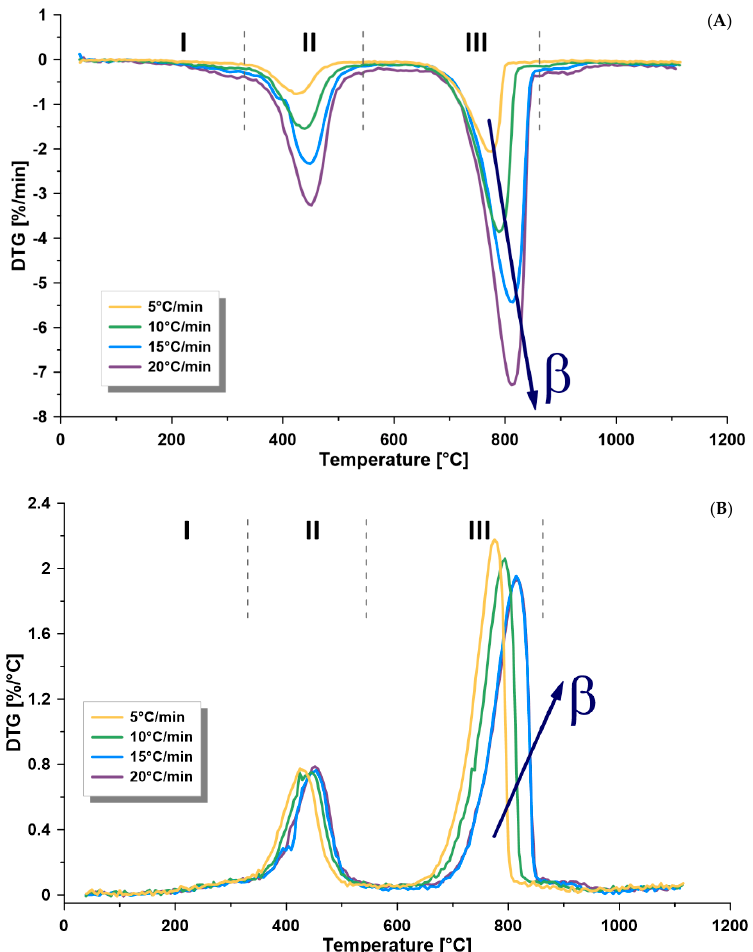
Figure 2. First derivative thermogravimetric (TG) curves, with respect to ( A ) time and ( B ) temperature (°C), of oil shale sample at four heating rates ( β ) of 5, 10, 15 and 20 °C/min, showing the three decomposition zones of oil shale (I. drying, II. pyrolysis, III. mineral decomposition), using thermogravimetric analysis (under nitrogen).